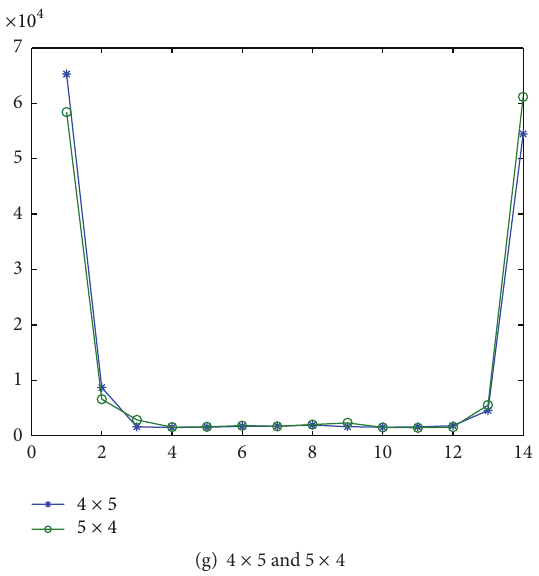
Figure 4: Evaluation result value curve with different neighborhood selection.